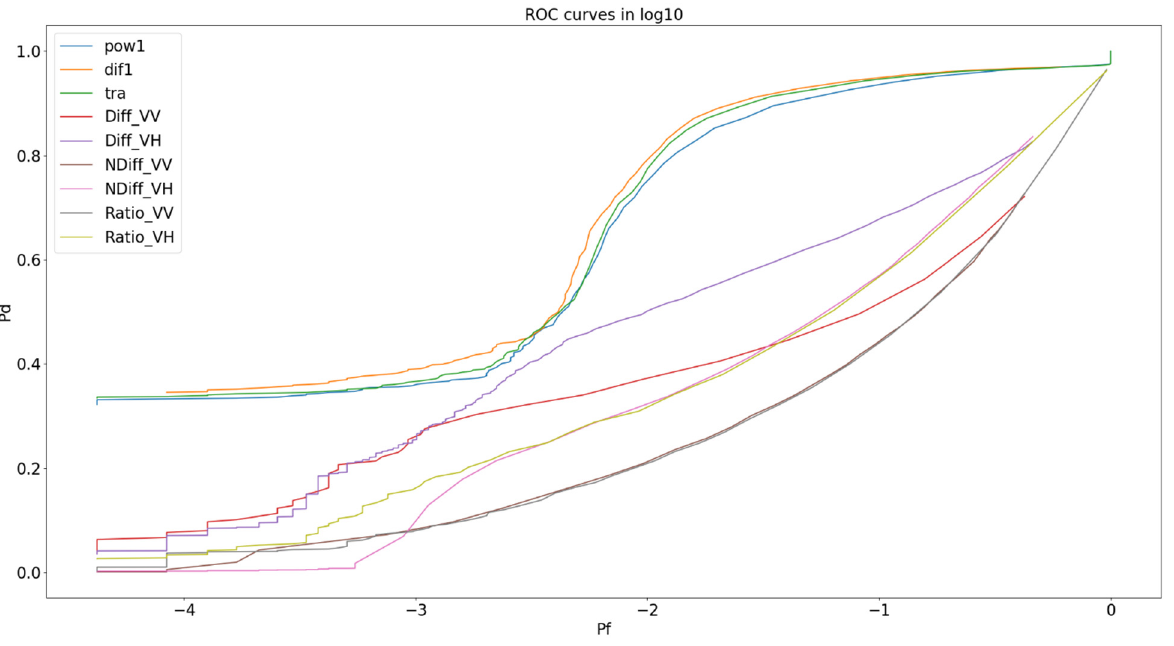
Figure 16. ROC curve in Log10 showing change detectors used on 19 October 2019 paddy & 24 April 2020 data: Difference VV and VH (Diff_), Ratio VV and VH (Ratio_), Normalised Difference (NDiff_), Power Difference (Dif1), Power Ratio (Pow1) and Trace (HLT).